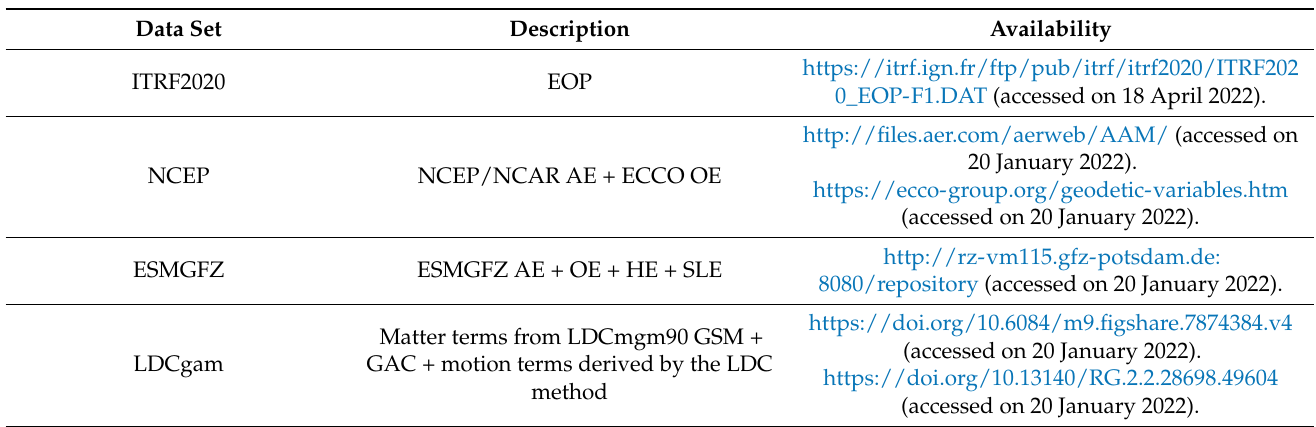
Table 1. Data sets adopted by this study.